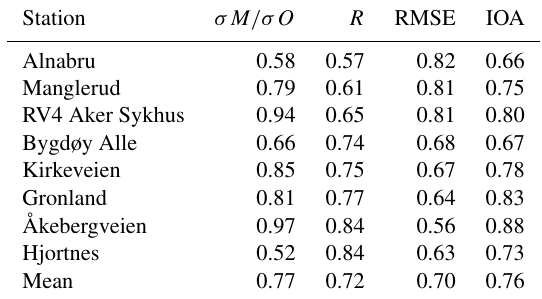
Table 9. Compiled statistics for the comparison between the ob- served and modelled NO 2 concentrations during the 10 to 13 De- cember pollution episode in Oslo. Statistics for each station are shown along with the mean of all of the statistics. σM/σO is the ratio of the model and observed standard deviation in NO 2 concen- trations, R is the Pearson correlation coefficient, RMSE is the root mean squared error (µgm − 3 ), and IOA is the index of agreement. These statistical metrics are explained in further detail in Appendix